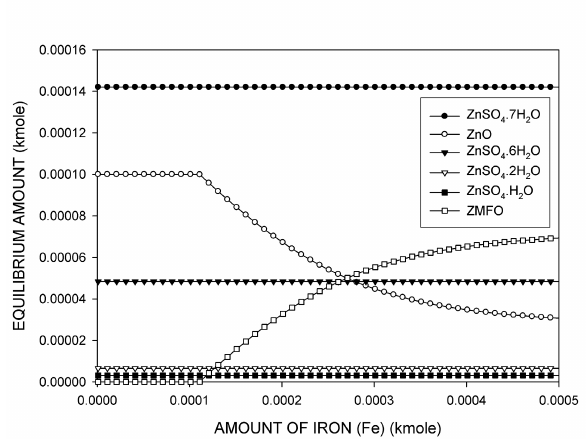
Figure 11. Effect of amount of calcium oxide on the equi- librium amounts of the zinc-containing species at 298 K for the Zn-Fe-Mn-O-C-H-S